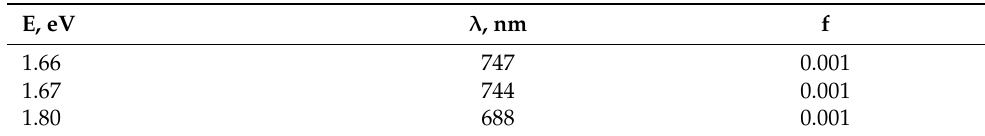
Table 5. Calculated absorption energies ( BHandHLYP ) for the open-shell singlet of the dinuclear copper(II) blue mycaminosate complex 4 in vacuo. The values in acetone are almost the same (within 5 nm).